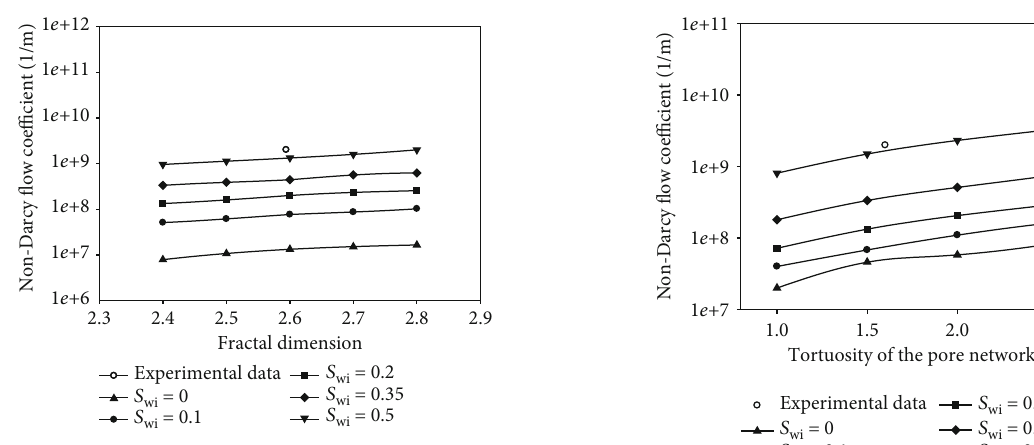
Figure 6: Curves of non-Darcy coe ffi cient and fractal dimension at di ff erent irreducible water saturation.